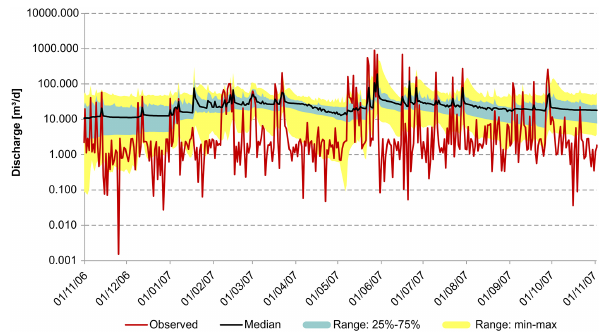
Figure 4. Discharge–frequency relationship of the second predic-